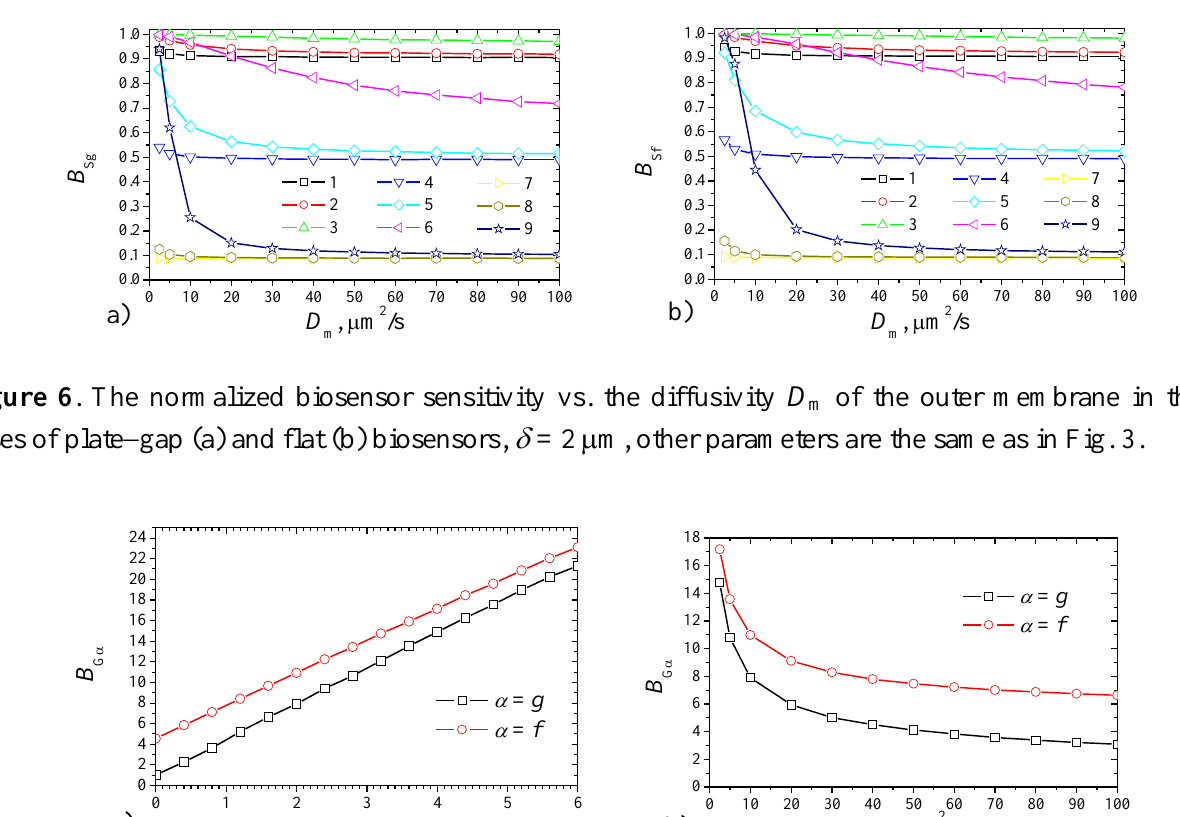
Figure 7 . The normalized maximal gradient vs. the thickness δ (a) and the diffusivity D = 1 mM/s, S = 1 mM/s, D = 0.1 µ m 2 /s (a), δ = 2 µ m (b), other parameters are outer membrane, V max 0 m the same as in Fig.